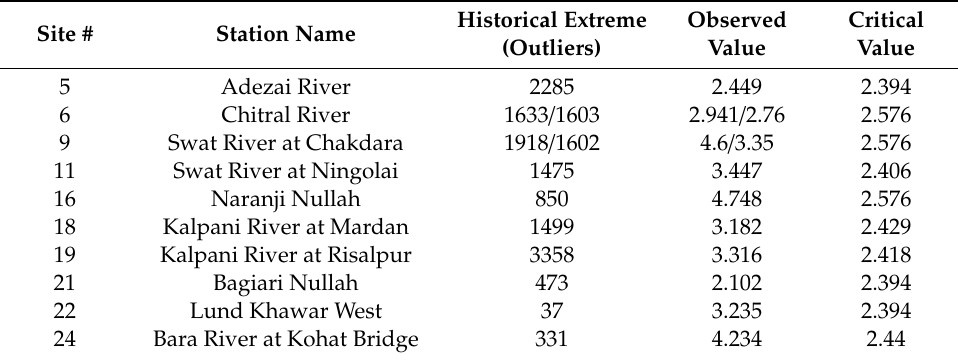
Table 4. Representation of detected outliers, as per Chauvenet’s